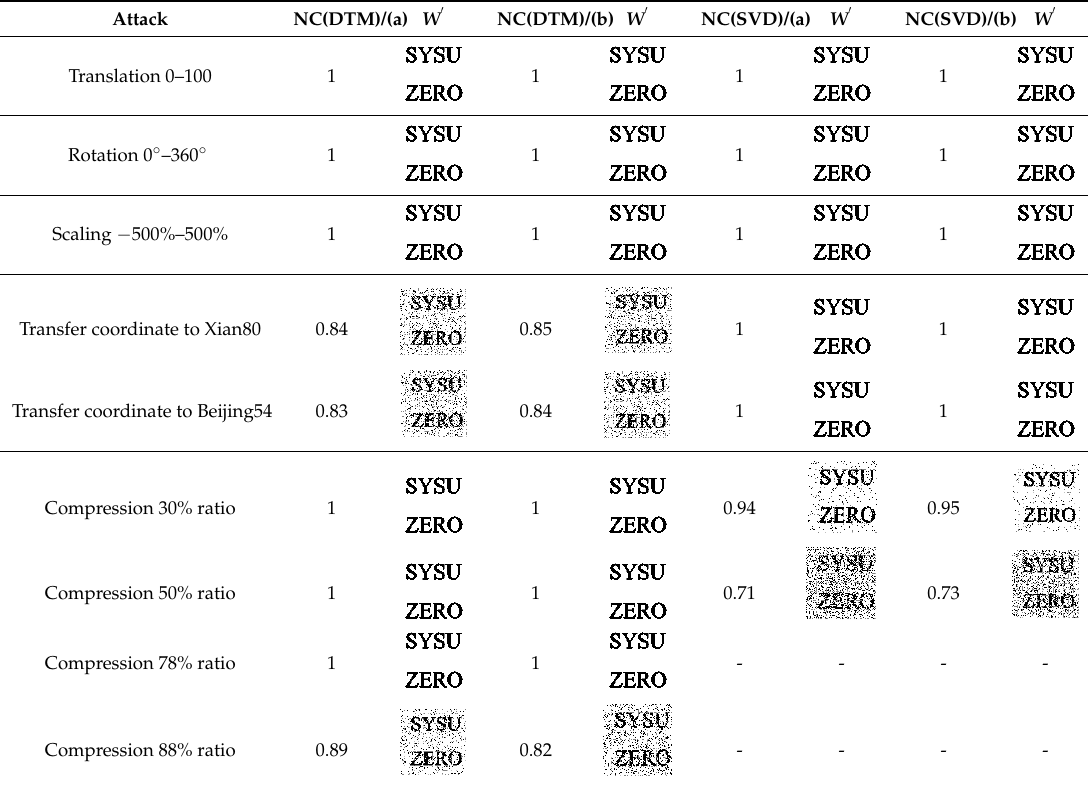
Table 4. Results of geometric attacks.